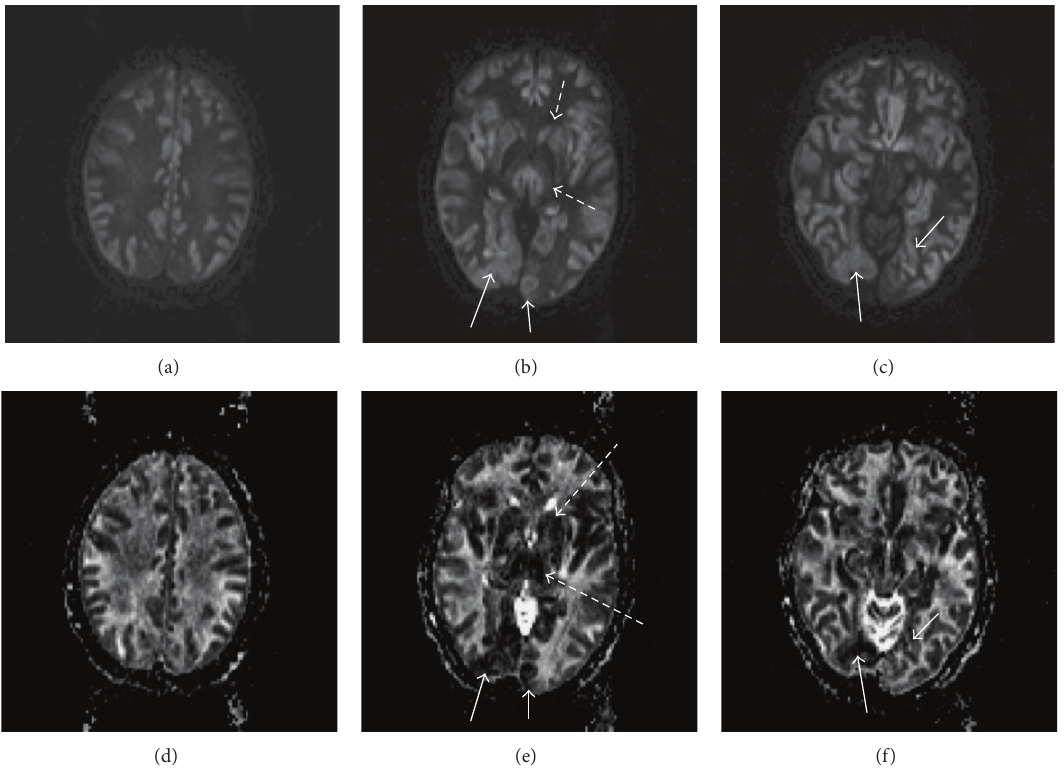
Figure 2: MRI of the brain four days after Figure 1. ((a), (b), and (c)) DTI images with hyperintense cortical diffusion restriction, now also involving ((b), dotted arrows) the thalami and basal ganglia, and ((b) and (c), solid arrows) the occipital cortices; ((d), (e), and (f)) axial apparent diffusion coefficient (ADC) images with hyperintensity of the previously hypointense cortical areas, confirming the transition from cytotoxic edema to extracellular edema, consistent with cerebral edema seen on CT. However, the areas of new diffusion restriction seen on the DTI have a hypointense ADC correlate ((e) and (f), corresponding solid and dotted arrows), suggesting they are due to a more recent